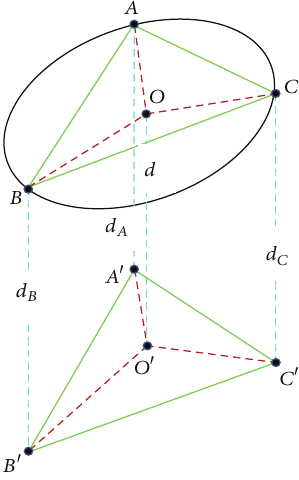
Figure 3: Measuring